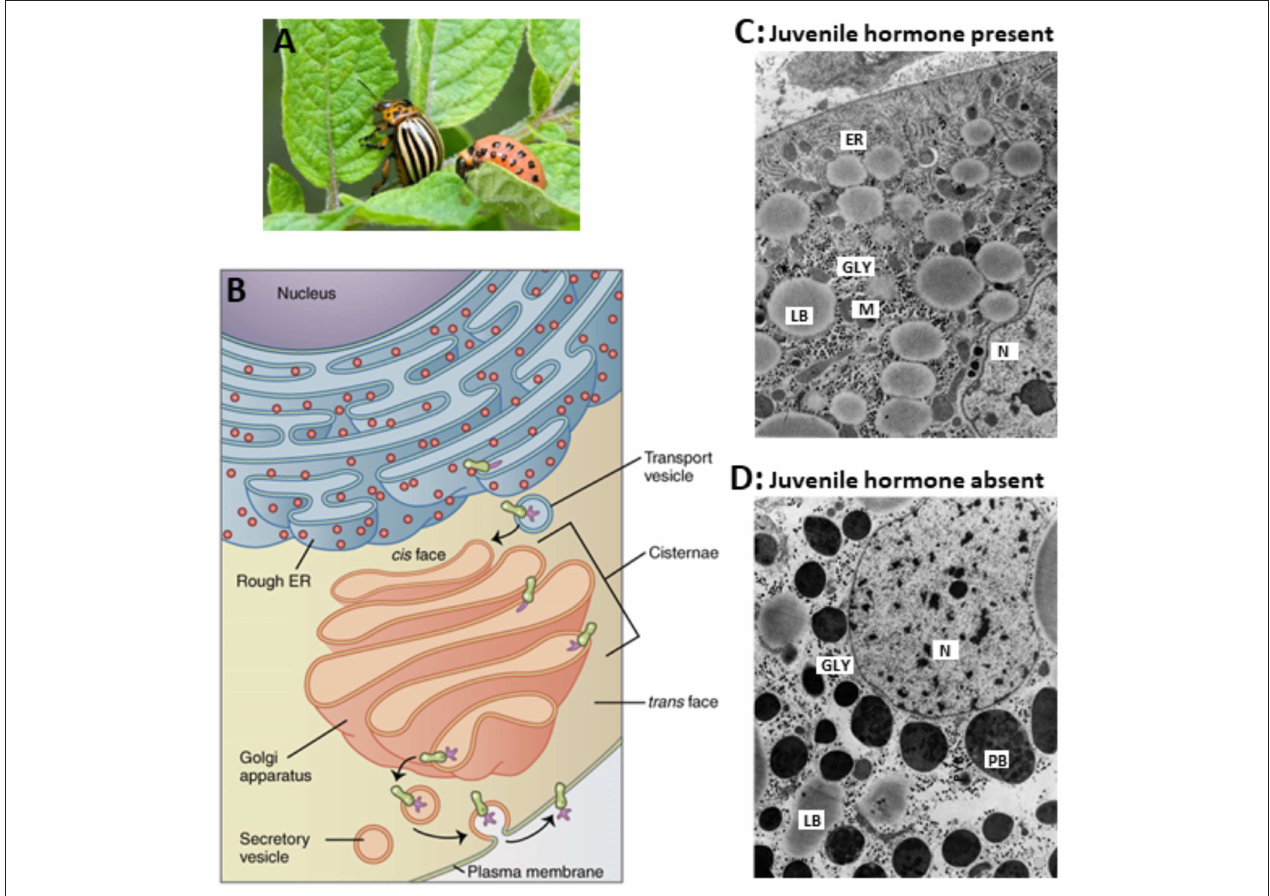
FIGURE 5 | Comparison of the ultrastructure of fat body cells of two adult females of the Colorado potato beetle, that were forced to undergo hypertrophy of the whole fat body under two different regimes. (A) Larva and adult. (B) RER-Golgi system. (C) This beetle was reared under long-day conditions which activate the corpora allata to produce JH. In addition, the beetle was ovariectomized. Thus, the hypertrophy happened in the presence of JH. (D) This beetle was reared under short-day conditions which inactivate the corpora allata . Thus, here the hypertrophy happened in the absence of Juvenile hormone. The comparison shows that in the absence of JH, there is an enormous accumulation of protein bodies (PB) containing “storage or diapause proteins” which result from the fact that the normal processing of secretory vesicles in the Golgi apparatus (B) gets jeopardized. How the Golgi is a target for JH is not known. In the absence of JH, very few mitochondria are present. ER, rough Endoplasmic Reticulum; GLY, glycogen; M, mitochondrion; N, nucleus; LB, lipid body; PB, protein body. Copyright: (A) from Google images, Open Access. (B) From Wikipedia: Golgi: Open Access. (C,D) Slightly modified from figures 70 and 71 in “Aggregaatsthesis” of De Loof (44) (Open Access). Additional information, e.g., on lysosomal activity, can be found in De Loof (44, 45) and in De Loof and Lagasse